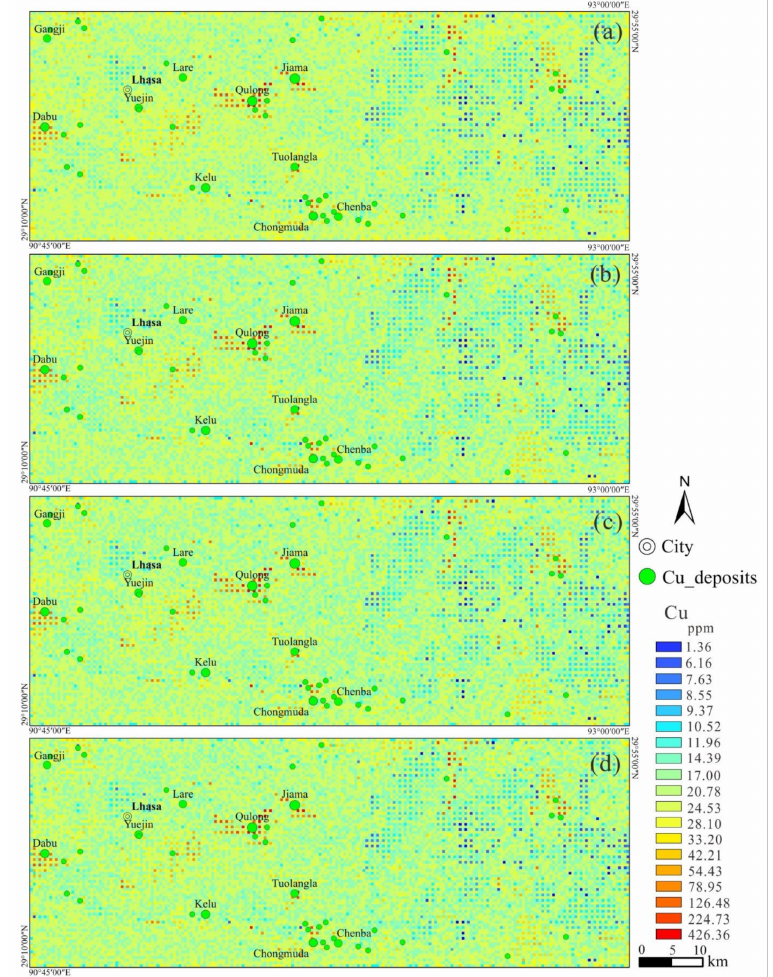
Figure 7. A random sample of 4 out of 200 realizations generated by direct simulation: ( a ) realization #15, ( b ) realization #58, ( c ) realization #130, and ( d ) realization